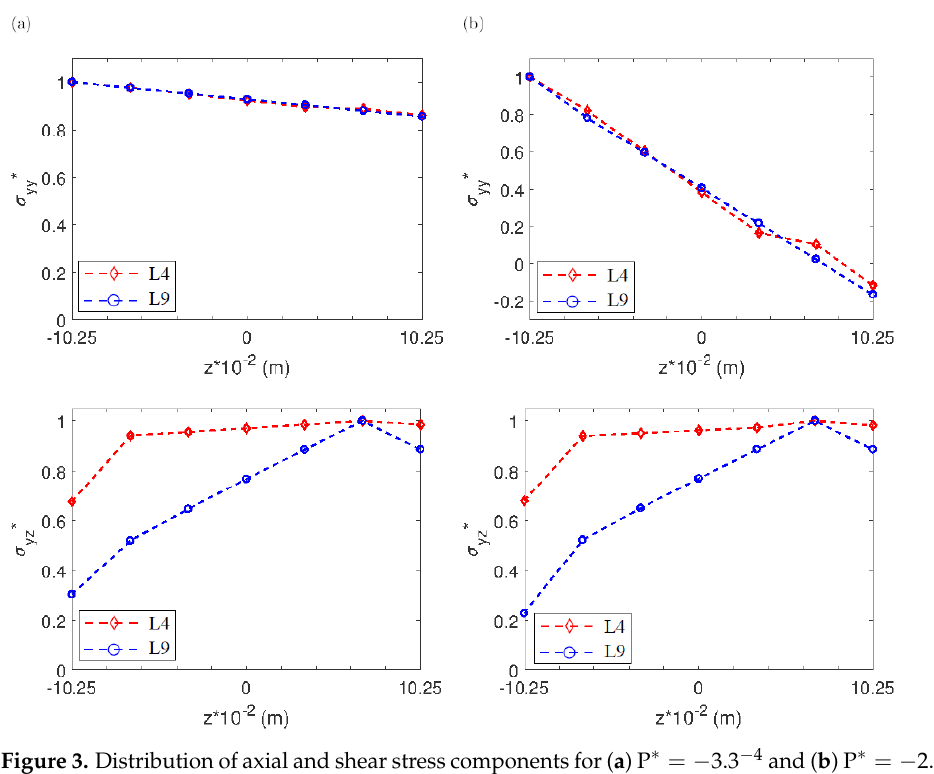
Figure 3. Distribution of axial and shear stress components for ( a ) P ∗ = − 3.3 − 4 and ( b ) P ∗ = − 2.95 − 3 loads in NL regime at L4 and L9 extensions at x = − a 2 /2 and y = L /2 in the isotropic box beam